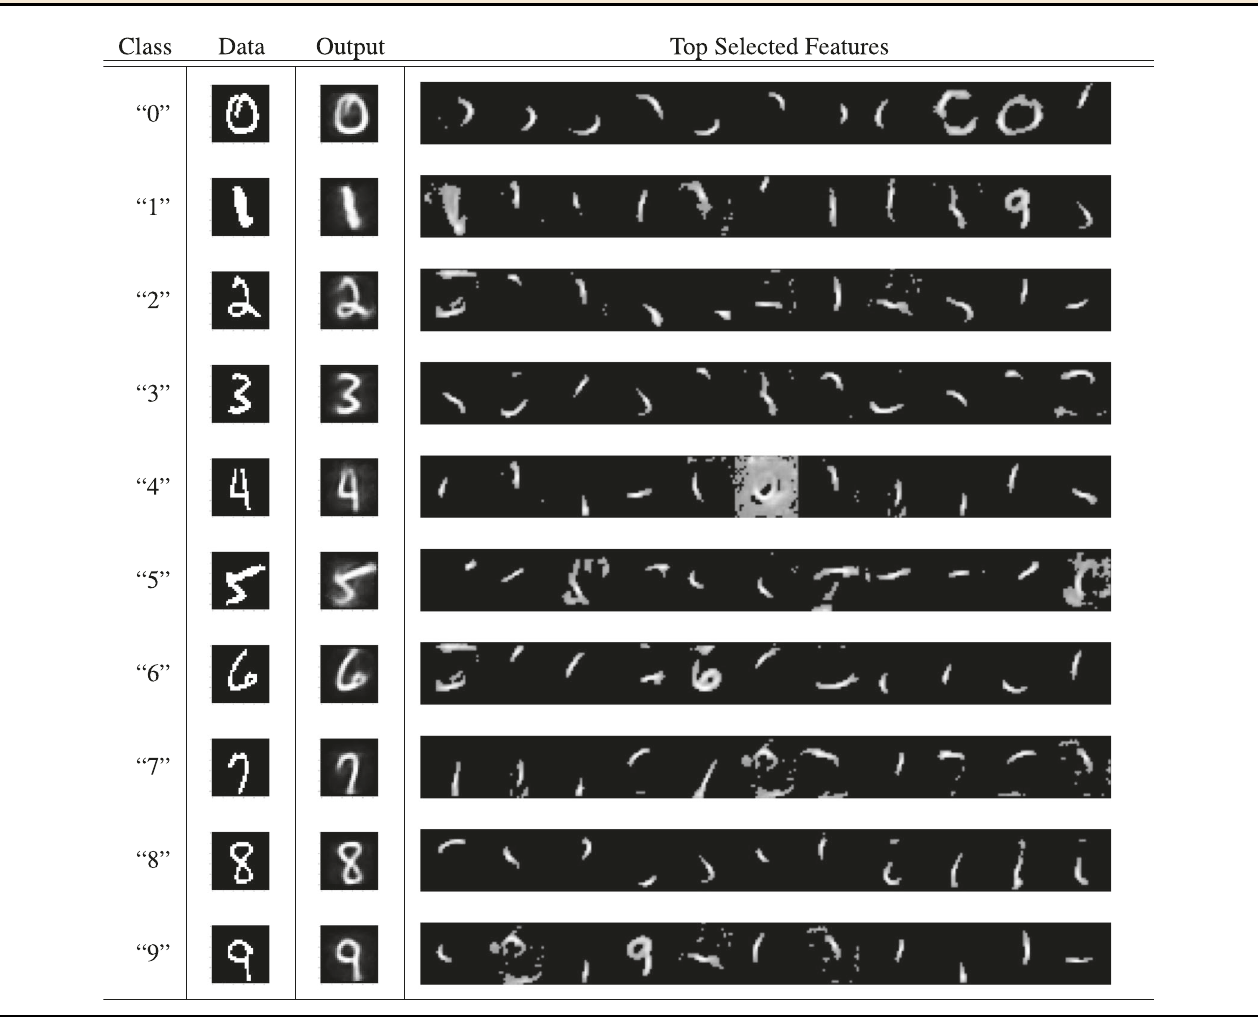
Table 4 Feature composition analysis of the generative neural coding